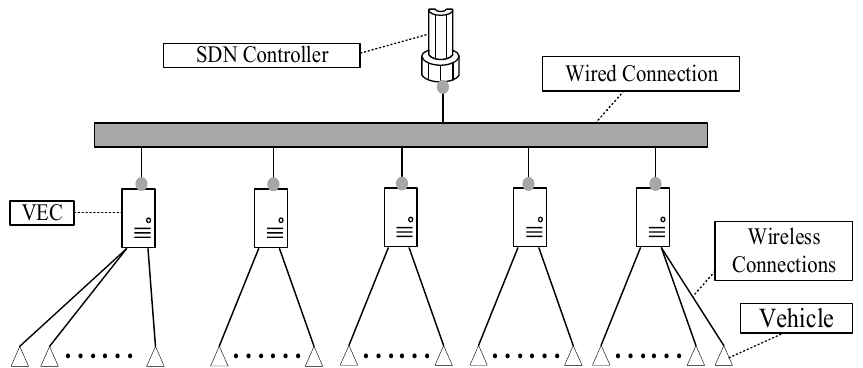
Figure 6. Network topology of the experiment.